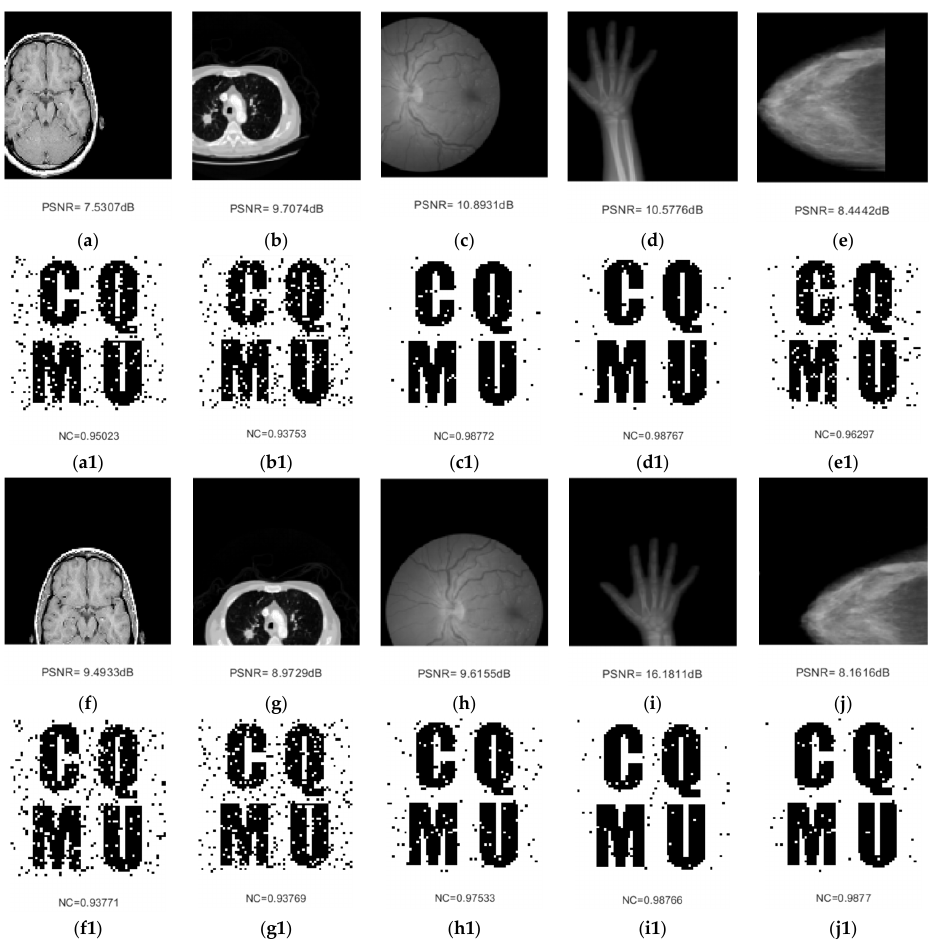
Figure 15. Attacked medical images and restored watermarking images under left translation 20% and down translation 30%: ( a , f , a1 , f1 ) brain and extracted watermarking image; ( b , g , b1 , g1 ) chest and extracted watermarking image; ( c , h , c1 , h1 ) fundus blood vessels and extracted watermarking image; ( d , i , d1 , i1 ) hand and extracted watermarking image; and ( e , j , e1 , j1 ) breast and extracted watermarking image. Table 7. The result under translation attacks.